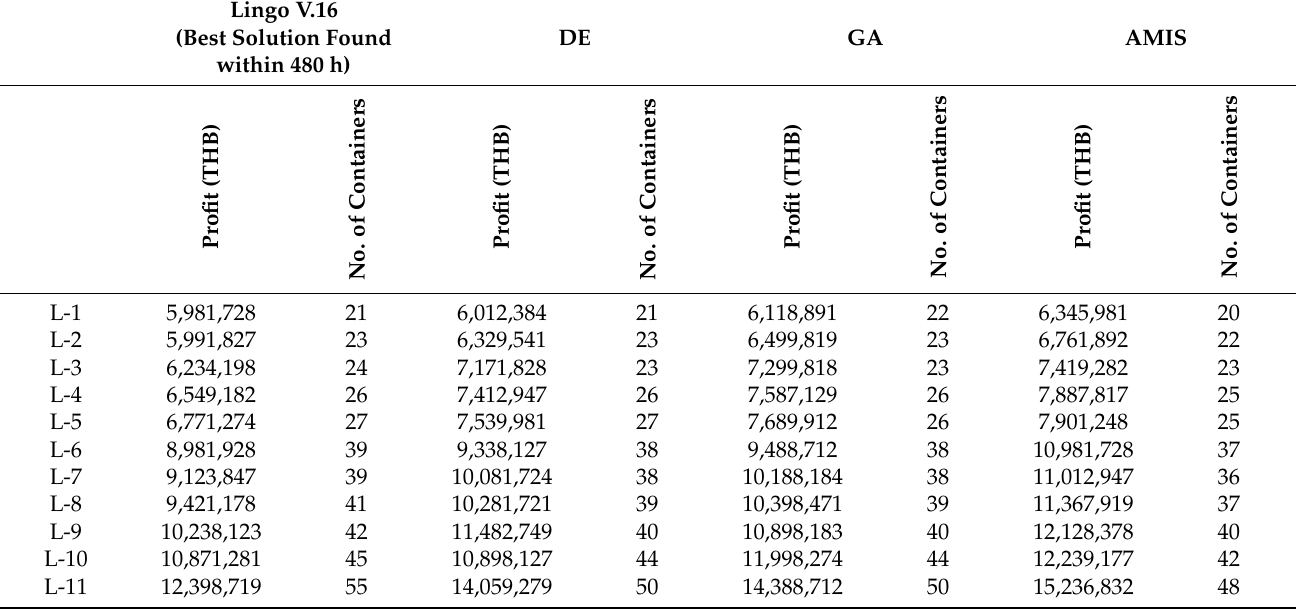
Table 16. Computational results of test instances with a large